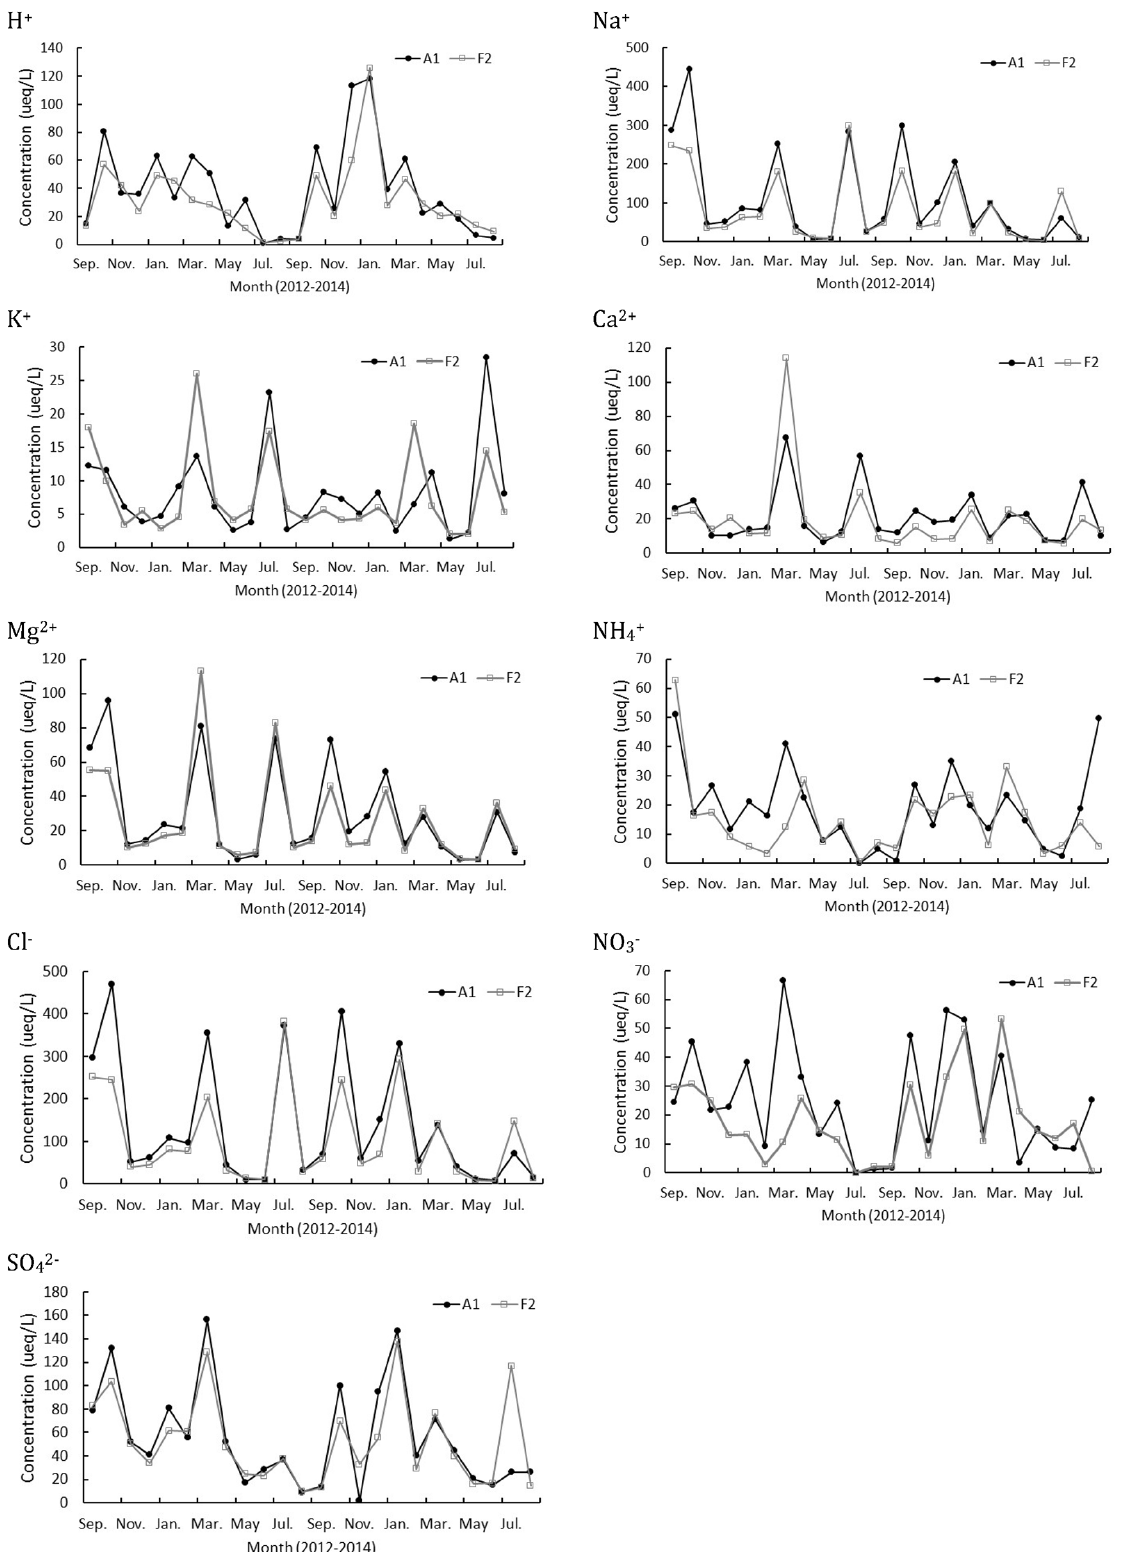
Figure 3. Monthly ion concentration (volume-weighted from weekly samples) of rainfall of watersheds A1 and F2.